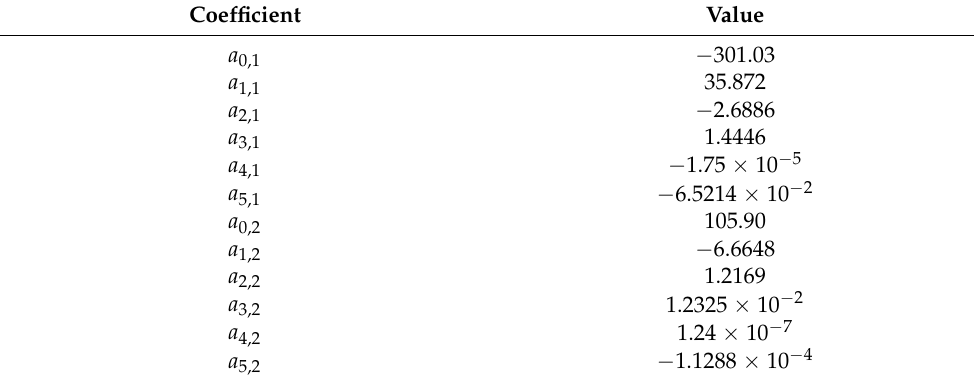
Table A1. Coefficient values for the multilinear regression in Equation (A1).